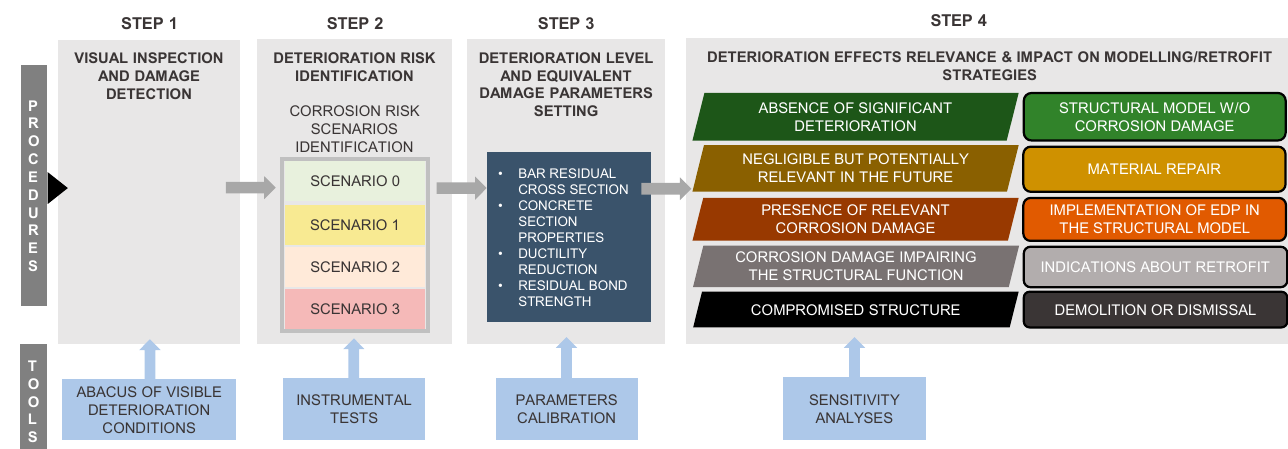
Figure 2. Steps of the DEMSA protocol: (1) visual inspection, (2) definition of the deterioration risk by identifying a corrosion risk scenario (CRS), (3) estimate of the deterioration level by means of equivalent damage parameters (EDP), (4) definition of the deterioration effects’ relevance on structures and the actions to be implemented in the structural model/preliminary selection of the renovation strategy.